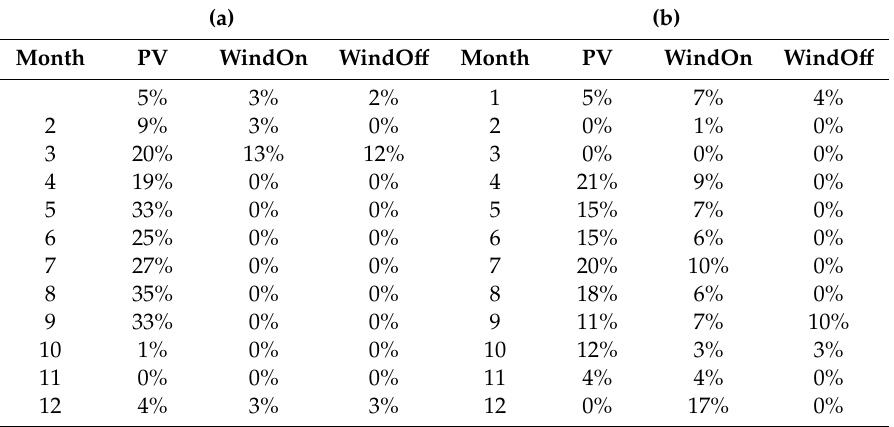
Table 4. Market share cross influence caused by PV ( a ) and wind onshore respectively ( b